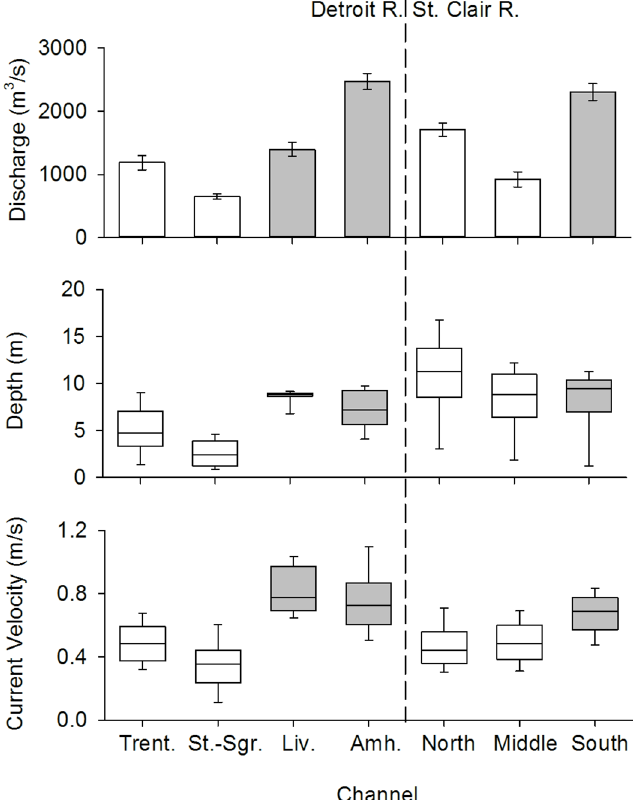
Fig 4. Current hydraulic and bathymetric characteristics of navigation channels (shaded) and other main channels in the lower Detroit and St. Clair rivers. Trent. = Trenton Channel,St.-Sgr. = Sugar I.-to- Stony I. channel,Liv. = Livingstone Channel,Amh. = Amherstburg Channel, Upper panel :mean annual discharge( ± 95% confidenceinterval). Data from Table 3 of Holtschlag and Koschik [27]. Middlepanel : Variation(median and quartiles)in channeldepth. Error bars representthe 10th and 90th percentiles. Data provided by the U.S. Army Corps of Engineers-Detroit District. Lower panel :Variation(medianand quartiles) in channeldepth-averaged current velocity. Data providedby the NOAA-Great Lakes Environmental Research Laboratory.Error bars represent the 10th and 90th percentiles.